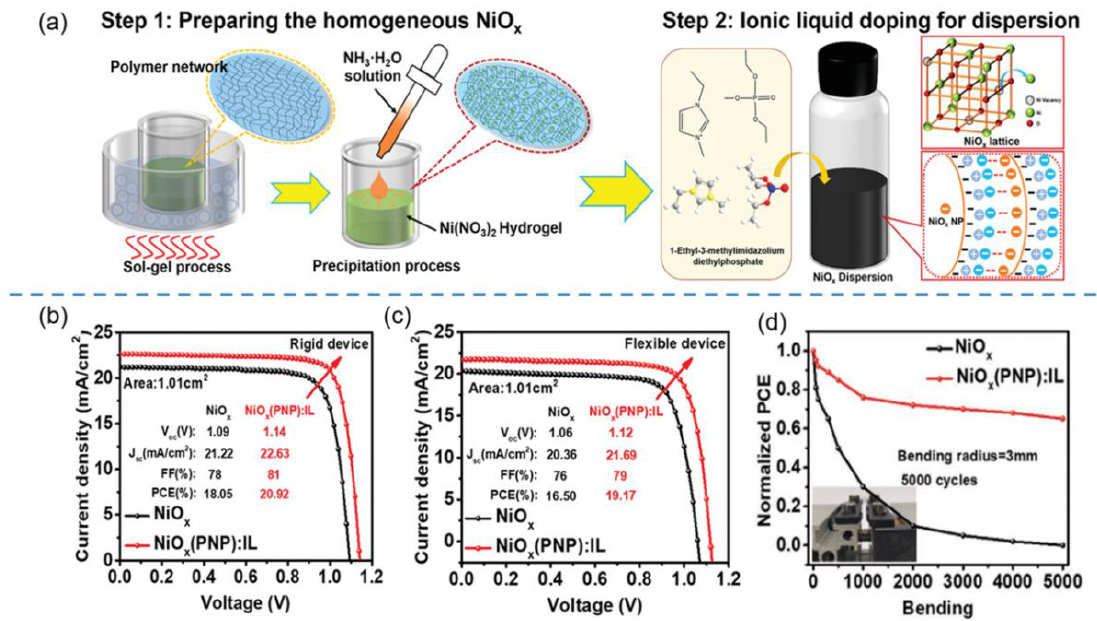
Figure 3. ( a ) Schematic diagrams of highly dispersed NiO x colloidal solutions prepared by PNP- based sol-gel method; ( b ) J–V curves of the rigid PSCs with NiO x and NiO x -PNP-EMDP IL as HTLs; ( c ) J–V curves of flexible PSCs with NiO x and NiO x -PNP-EMDP IL as HTLs; ( d ) the PCE stability of flexible PSCs with NiO x and NiO x -PNP-EMDP IL HTLs as a function of the number of bending cycles. Reproduced from [118], with permission from the Advanced Functional Materials, 2021.